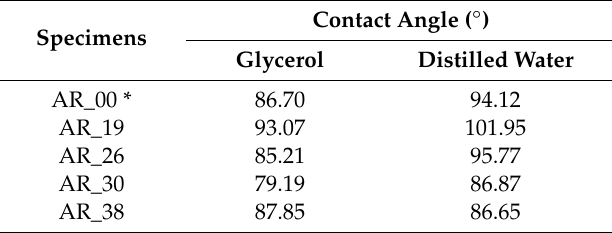
Table 4. Summary of the contact angle and surface energy results for the 5 samples. Contact Angle ( ◦ ) Specimens Glycerol